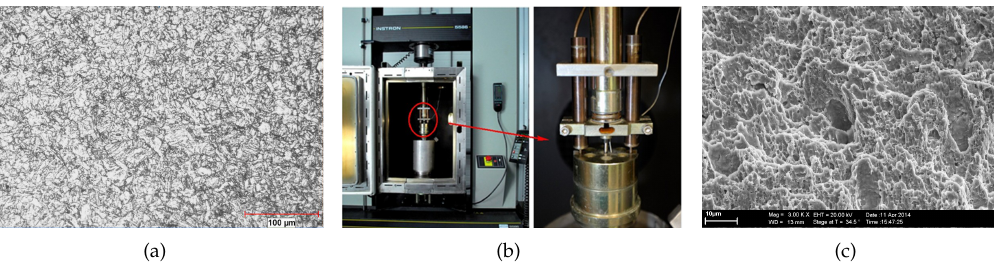
Figure 2. ( a ) Optical micrograph of the tempered martensitic structure of P91 steel; ( b ) Experimental setup for SP testing; ( c ) Fracture surface of the unnotched 0.5mm thick SP disk showing the dimpled